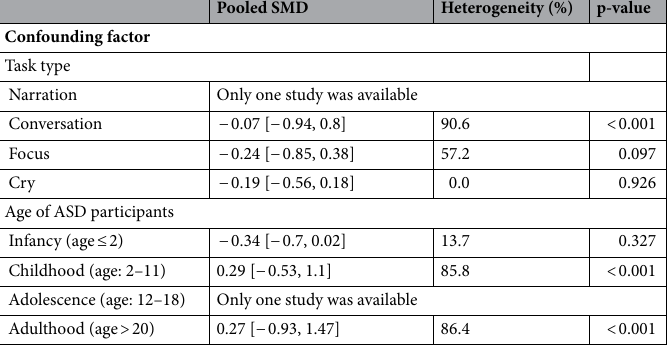
Pooled SMD Heterogeneity (%)